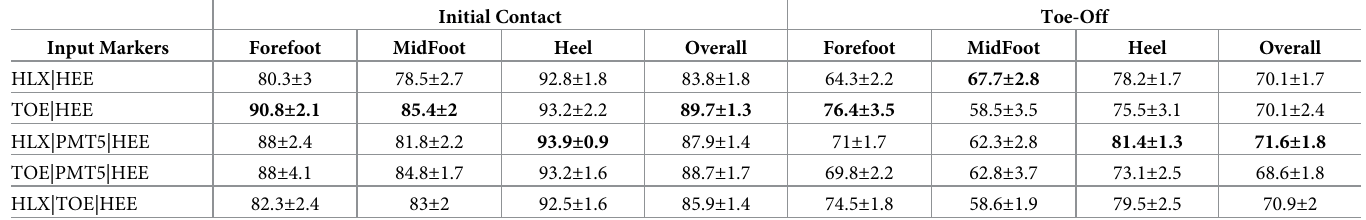
Table 3. Percentage of true events that have a corresponding predicted event within ± 16ms.